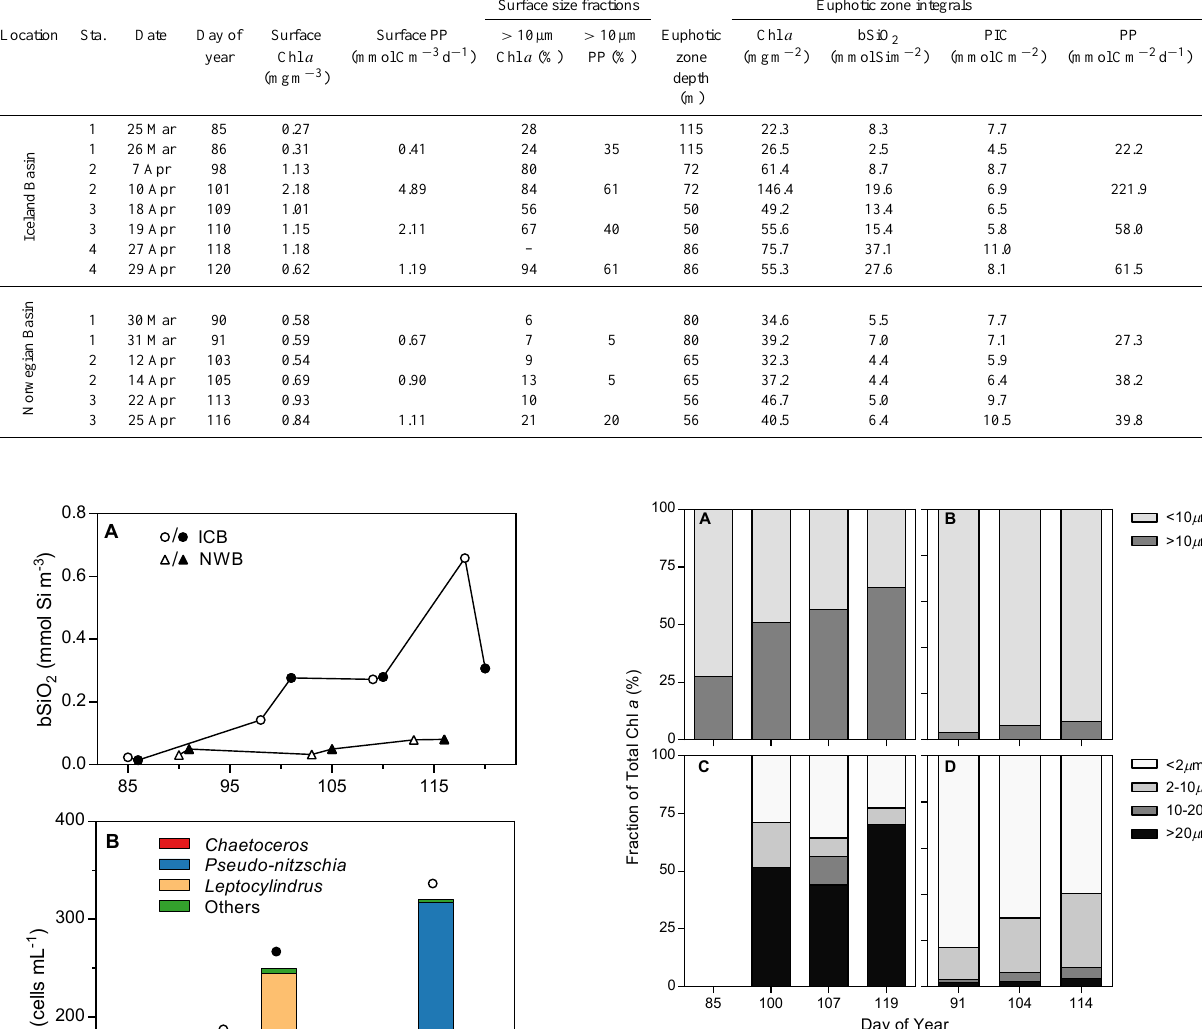
Surface size fractions Euphotic zone integrals